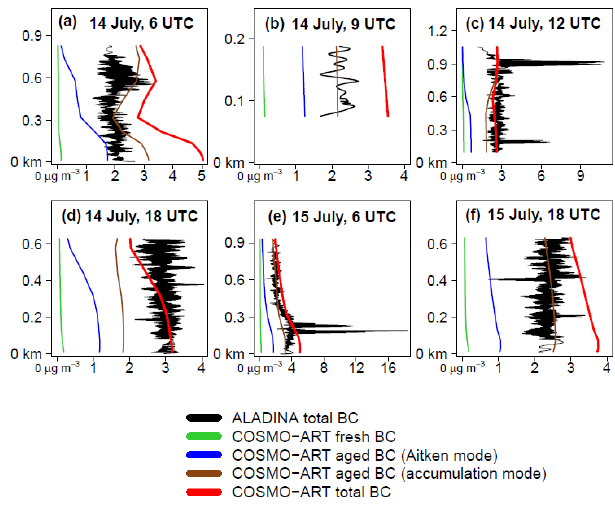
Figure 10. Vertical profiles of BC (µgm − 3 ) at Savè for (a– d) 14 July 2016 and (e–f) 15 July 2016. The ALADINA observa- tions of total BC are denoted in black; the COSMO-ART results for fresh BC, aged BC (Aitken mode), aged BC (accumulation mode), and total BC are shown in green, blue, brown, and red, respectively. The observations were temporally assigned to the 3-hourly model output with a deviation not larger than 1h and by subsequently in- terpolating the model data to the ALADINA altitudes. Within these time steps, ALADINA conducted several ascents and descents. It is assumed that the observations within the time steps are measured